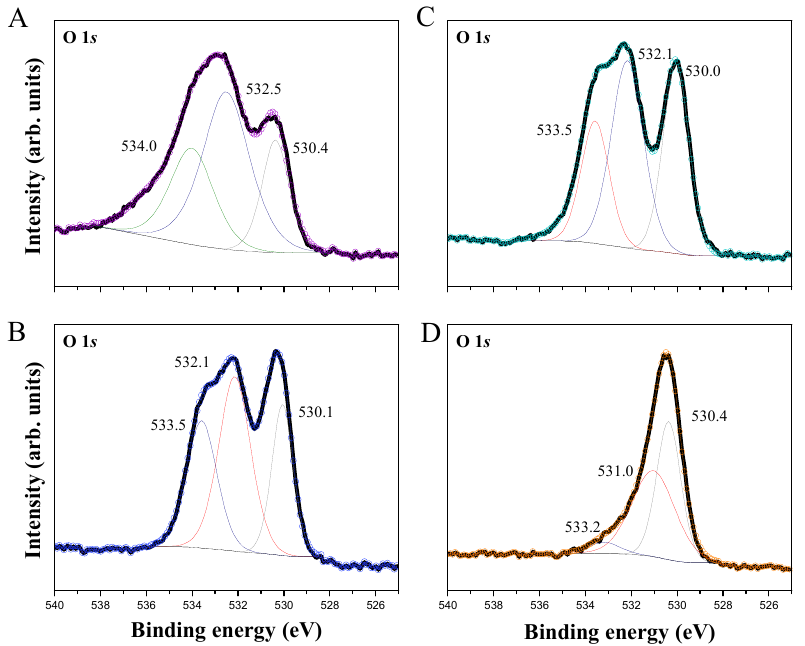
Figure 2. High-resolution XPS spectra of the O 1s orbital of α -Ag 2 WO 4 ( A ), α -Ag 2 WO 4 -TA ( B ), α -Ag 2 WO 4 -BA ( C ), and α -Ag 2 WO 4 -CA ( D ) samples. Table 1. Calculated percentage values of the amount of L O , V O , and S O (%) based on the deconvolu- tion of the O 1 s peaks as a function of BE.